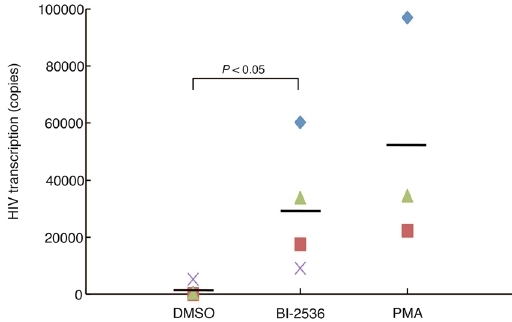
Figure 4. BI-2536 reactivates latent HIV-1 provirus in primary cells from HIV-1 infected patients. Peripheral blood mononuclear cells (PBMCs) derived from four different HIV-1 patients were treated with dimethyl sulfoxide (DMSO) or with 1 μ M BI-2536. PBMCs from three patients were treated with 10 ng/mL phorbol-12- myristate-13-acetate (PMA) for 16 hours. Total RNA was prepared from the cells. Gag mRNA expression was measured by quantitative RT-PCR. Viral copy number per one million cells was shown as the mean of triplicate determination. The horizontal lines show the mean of the samples treated with each regent. P -values were determined using the Mann-Whitney U test for nonparametric data. P -values are significant if less than